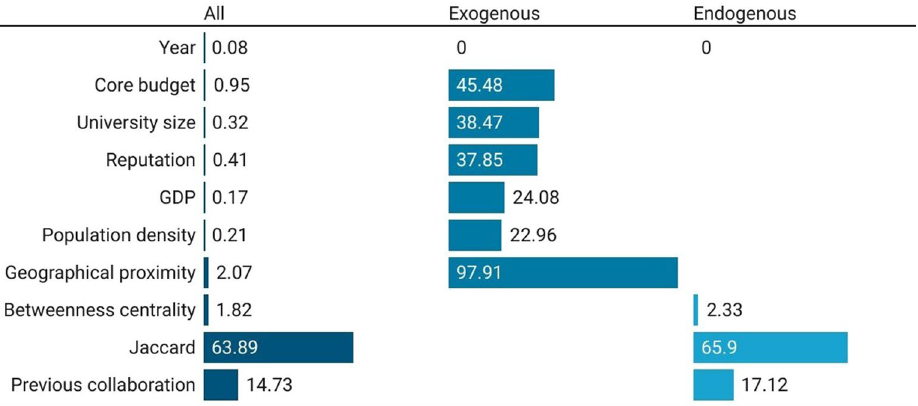
Figure 2. Feature-importance scores for European universities’ co-publication prediction in Social Sciences and Humanities. Three models considered: with all, with only exogenous, and with only endogenous